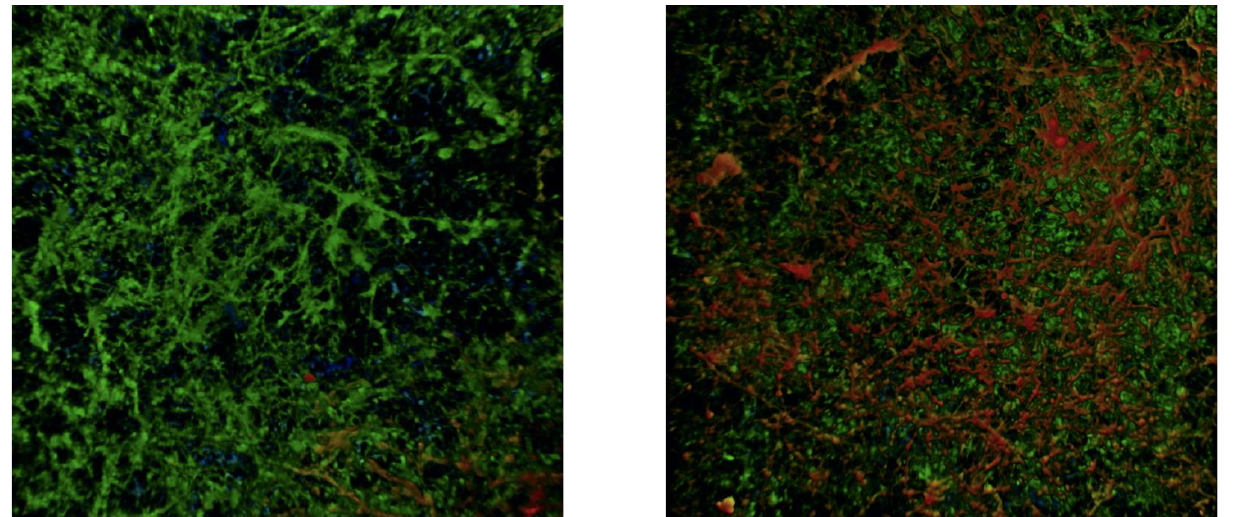
Figure 4. Confocal microscopy images at 10× magnification of the Amp-B-only-treated biofilm ( left ) and the biofilm treated with Amp B + electrohydraulic shockwaves ( right ) using calcofluor white staining. Qualitative comparison using false color enhanced red indicating deeper, fuller ECM, and biofilm for the shockwave sample.